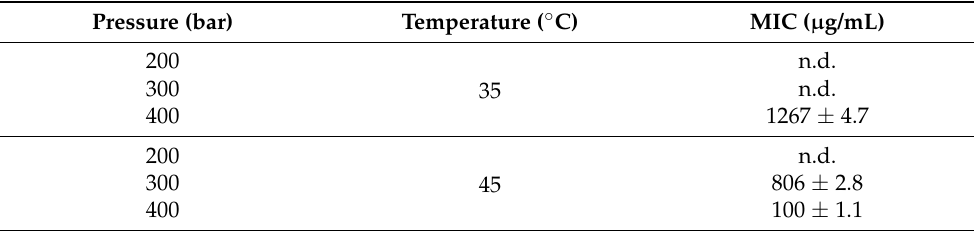
Table 2. Antibacterial activity (MIC) against Staphylococcus aureus of the extracts obtained from orange peel under different